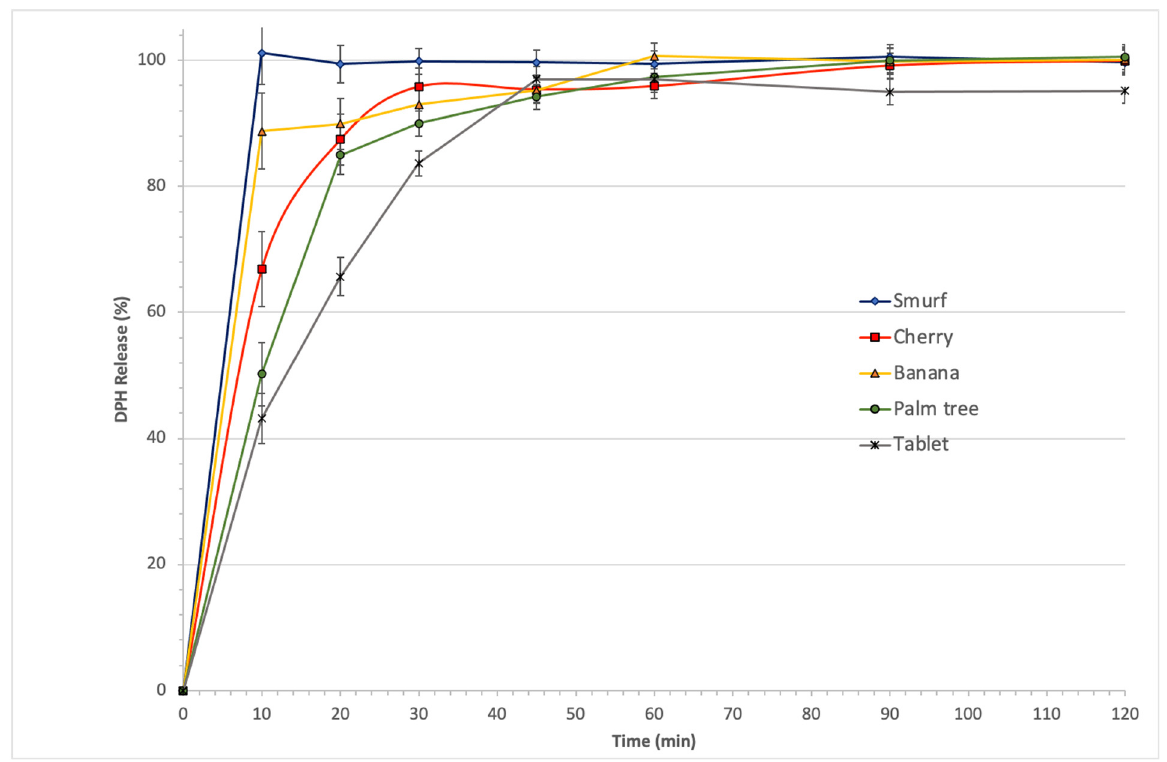
Figure 8. DPH release from 3D printed fruit chews in pH 6.5 for 2 h.